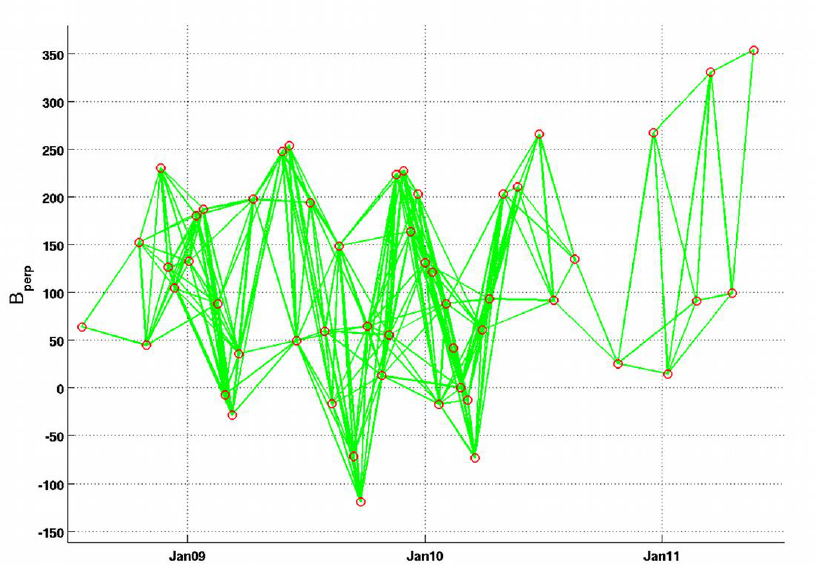
Figure 5. The network of the individual Small Baseline Subset (SBAS) interferograms for the TSX dataset for Staufen. The red circles represent the images and the green lines the pairs from which interferograms were generated. The vertical axis is the perpendicular baseline in